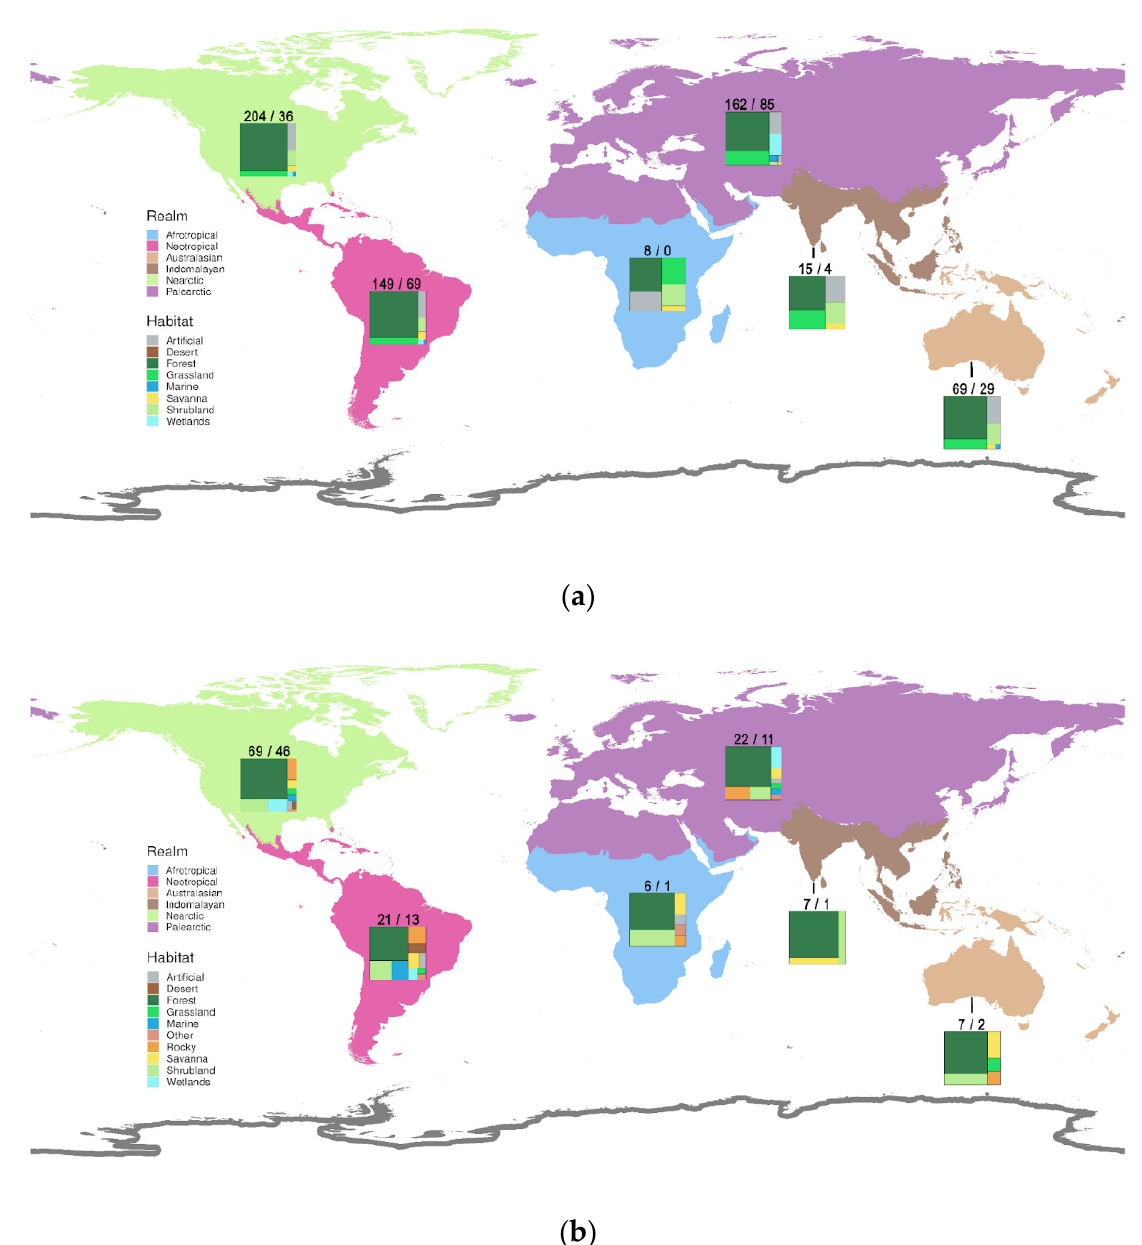
Figure 9. Number of assessed species/threatened species in different biogeographic realms for ( a ) nonlichenized fungi and ( b ) lichens. The boxes illustrate the corresponding habitat occupied by these species. Note that species may be present in more than one habitat. Oceania and Antarctica were excluded from the maps.